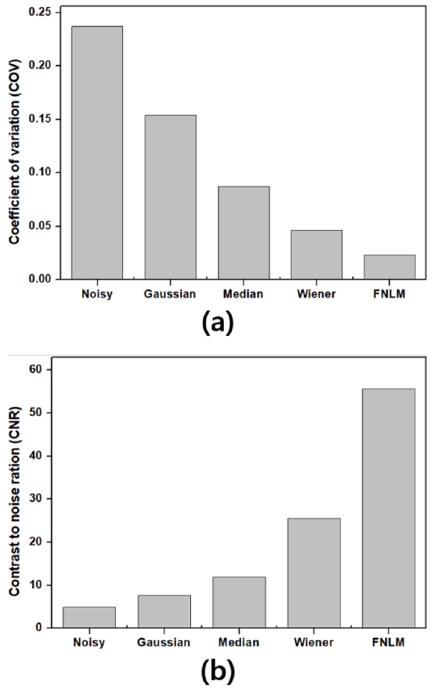
Figure 4. The ( a ) coefficient of variation (COV) and ( b ) contrast-to-noise ratio (CNR) metrics computed in the set ROIs to evaluate the noise level of the reconstructed image obtained from the MASH phantom.